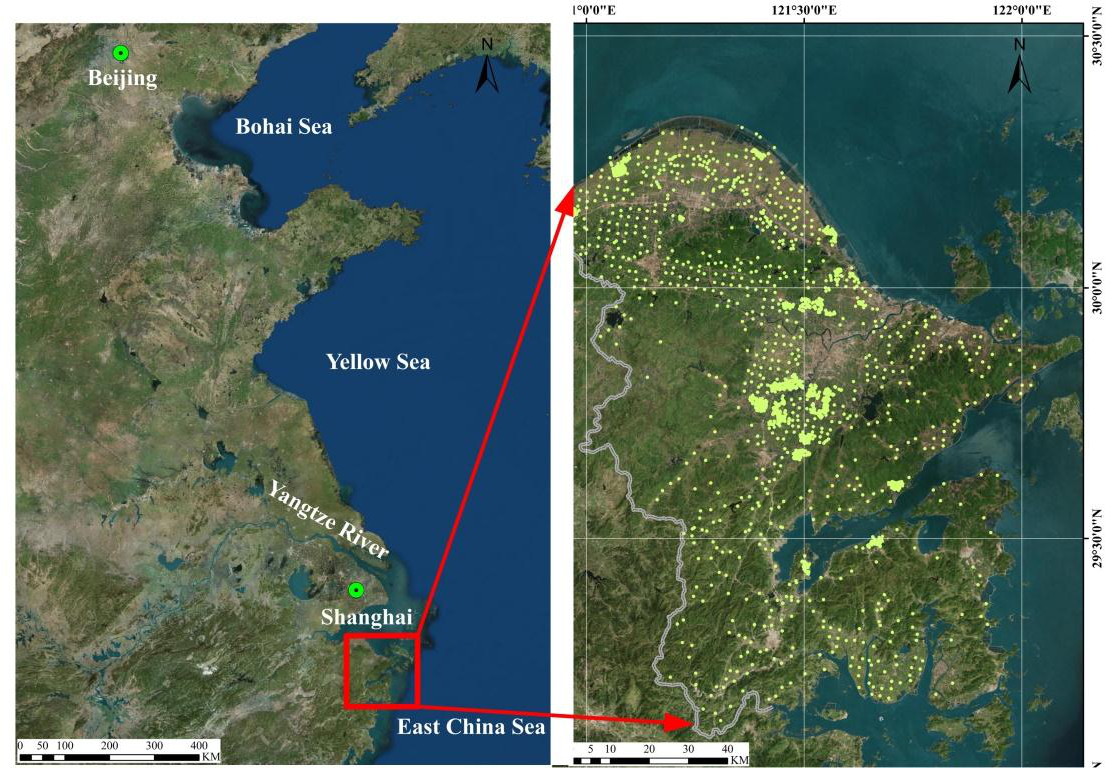
Figure 1. Location of the study area and sampling points.